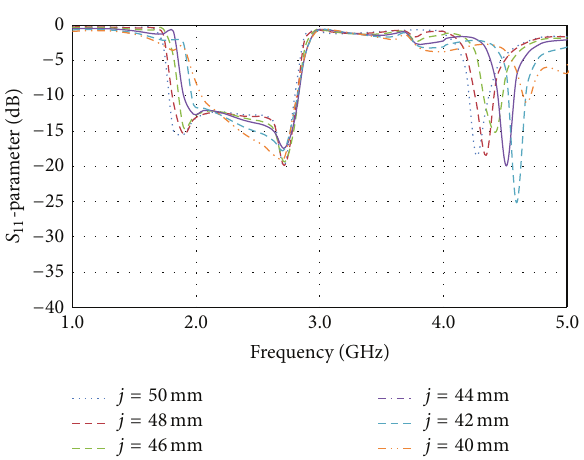
Figure 4: Return loss response for change in the value of “ 𝑏 ” and “ 𝑐 .”